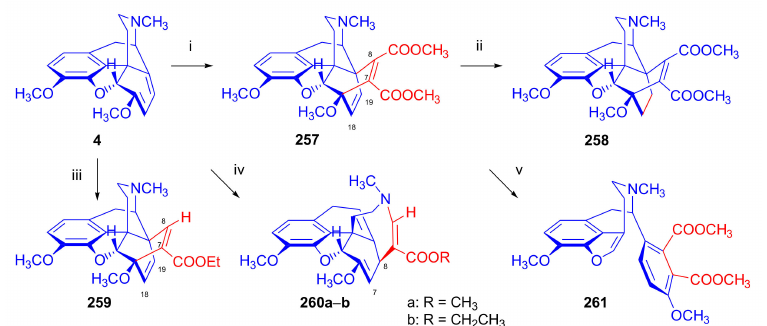
Figure 70. Reaction of thebaine with acetylenic dienophiles. Reagents and conditions : (i): dimethyl acetylenedicarboxylate (DMA, 1 equiv.), benzene, 50 ◦ C, 1 h, 90%; (ii): H 2 , Pd-C, glacial acetic acid, 60 min; (iii): ethyl propiolate, 1.57 equiv., benzene, 50 ◦ C, 8 h, 5.8%; (iv): ethyl propiolate or methyl propiolate, acetonitrile, room temperature, 30 min, quantitative yield; and (v): di- n -butylether, reflux, 10–15